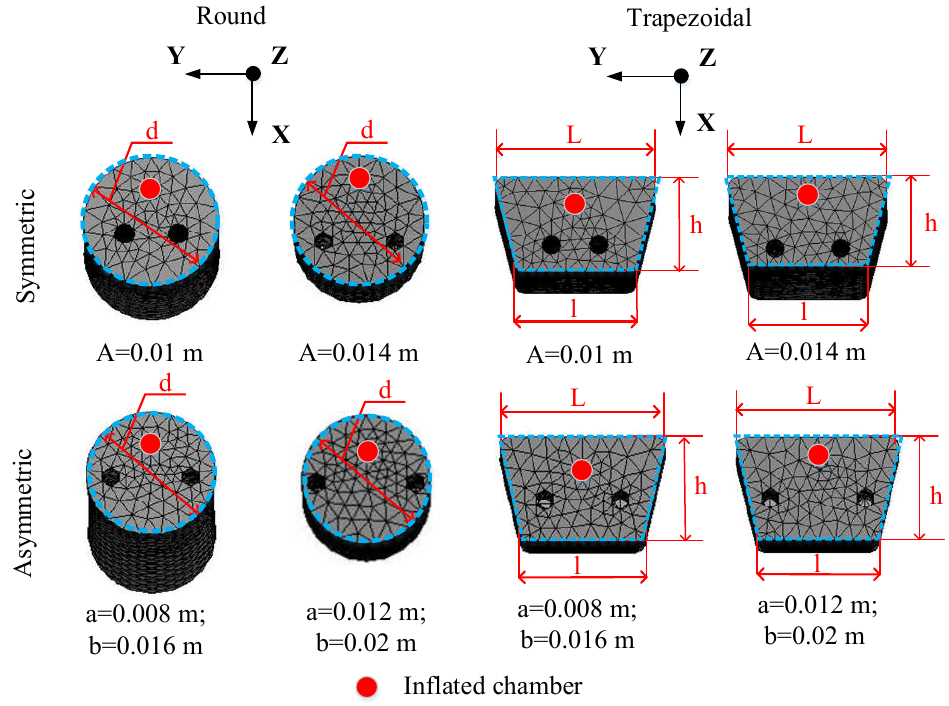
Figure 2. Top view of the deformation results in ANSYS when the middle chamber is inflated: Round cross-section with symmetrically located chambers, with chamber distance values of 0.01 m and 0.014 m ( A value in the figure); round cross-section with asymmetric locations, with chamber distance values of 0.008 m, 0.016 m, 0.012 m, and 0.02 m ( a , b values in the figure); trapezoidal cross-section with symmetrically located chambers, with chamber distance values of 0.01 m and 0.014 m ( A value in the figure); trapezoidal cross-section with asymmetrically located chambers, with chamber distance values of 0.008 m, 0.016 m, 0.012 m, and 0.02 m ( a , b values in the figure). The figure contains the base dimensions of each cross-section. All the round cross-sectioned models have a diameter of 0.026 m ( d ) and finger height of 0.12 m, while all the trapezoidal cross-sectioned fingers have a big base length of 0.035 m ( L ), a small base length of 0.025 m ( l ), and a leg length of 0.02 m ( h ). The deformation of each model is shown in the dark part and the dashed line represents the initial position of each finger.